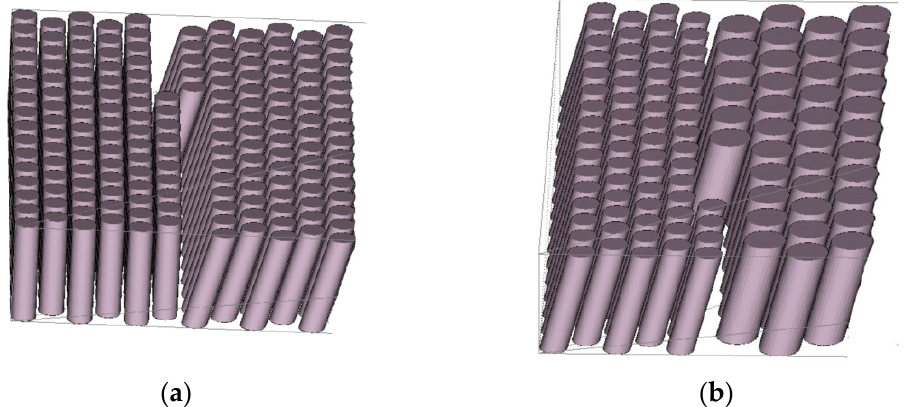
Figure 12. Examples of combinations of two sections using “swap” technique: ( a ) cylinders of the same size but with different inclinations, ( b ) cylinders with the same inclinations but of different size.